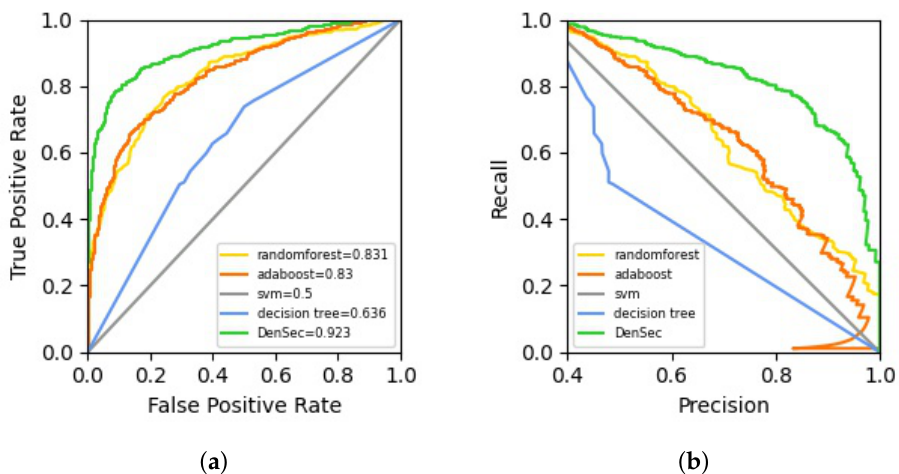
Figure 2. The ROC and Precision-Recall curves for CSF protein prediction differentiation of DenSec versus other machine learning models: ( a ) the ROCs on the testing dataset; ( b ) the Precision-Recall curves on the testing dataset.